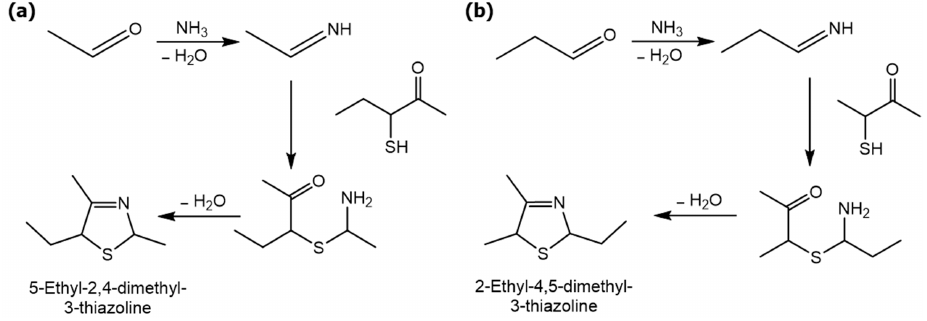
Figure 2. Proposed scheme for the formation of ( a ) 5-ethyl-2,4-dimethyl-3-thiazoline and ( b ) 2-ethyl- 4,5-dimethyl-3-thiazoline.